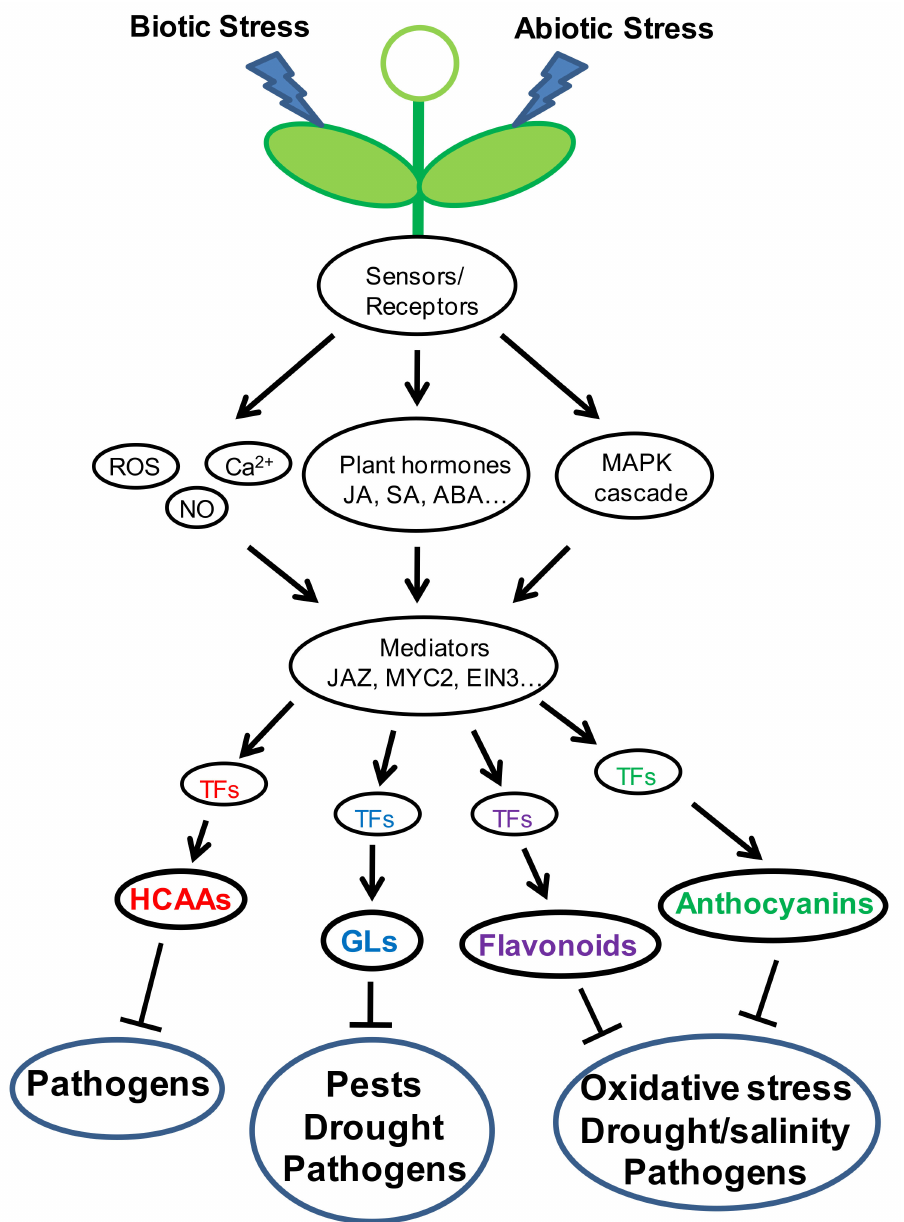
Figure 3. Signal transduction and regulation of secondary metabolism in response to biotic / abiotic stresses in Arabidopsis. Four types of secondary metabolites in Arabidopsis involved in di ff erent resistances are exemplified to show the regulation of secondary metabolism by di ff erent transcription factors (TFs), which are mediated by the complicated upstream signaling pathways in response to stresses. The TFs and their corresponding regulated metabolites are labeled with the same